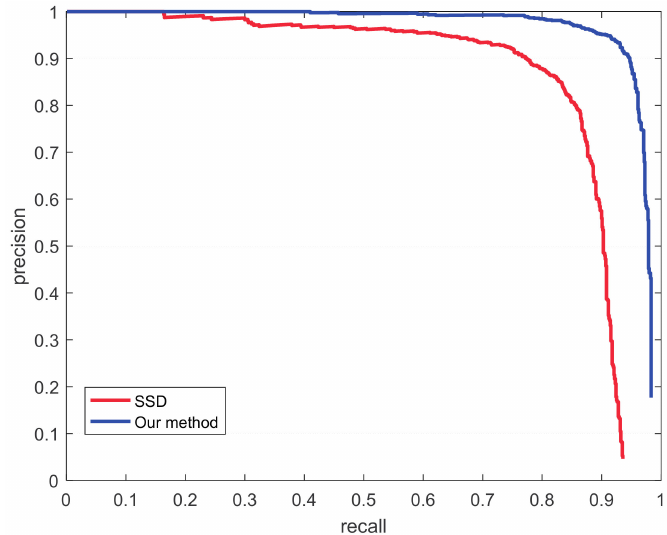
Figure 8. The Precision-Recall (PR) curve. The blue curve is the result of our method on the test set and the red one is the SSD. It can be seen that with the same precision, our method has an obvious advantage in the recall